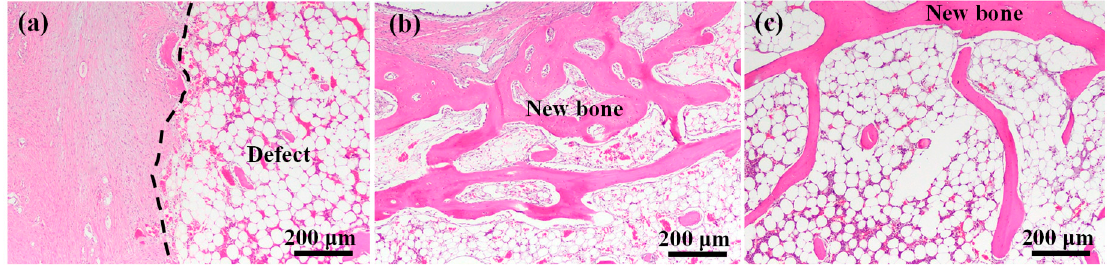
Figure 8. Images of H&E-stained bone tissue 8 weeks after implantation: ( a ) blank, ( b ) control, and ( c ) α -CSH samples.